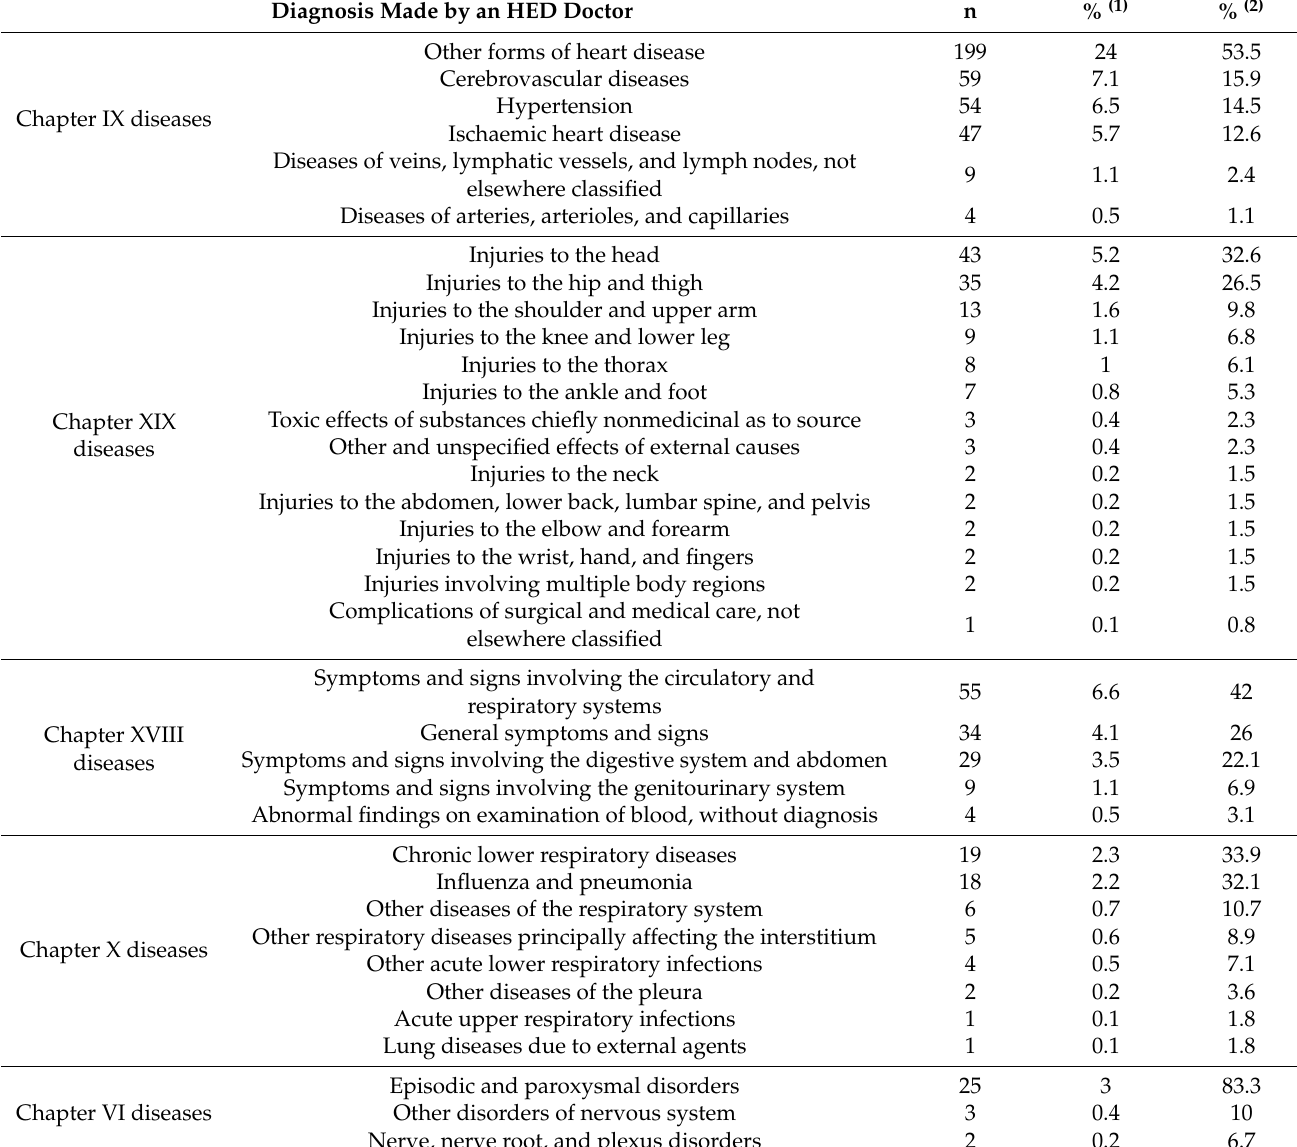
Table 5. Percentage distribution of the most common disease groups diagnosed by an HED